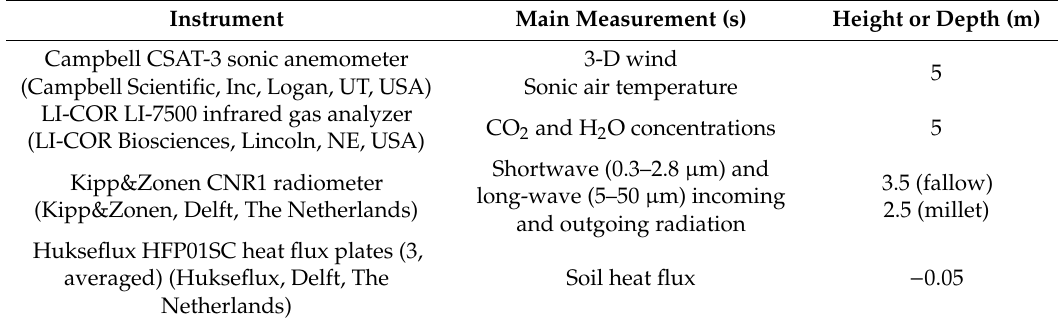
Table 2. Main observations used from the AMMA-CATCH eddy covariance (EC)-stations at Wankama, Niger.